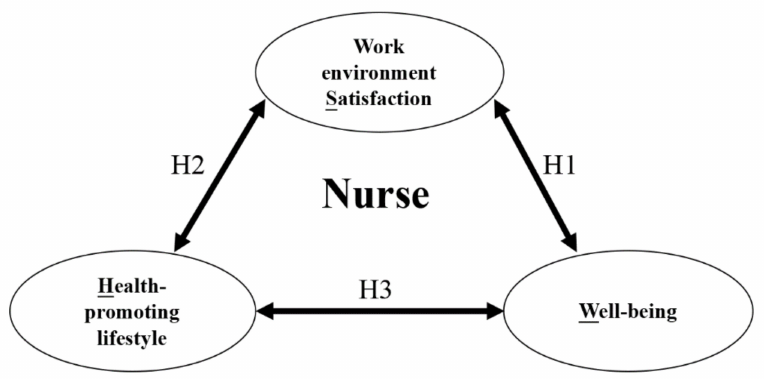
Figure1. ConceptualFrameworkIllustratingtheRelationshipsamongNurses’Well-being,Health-promoting lifestyles, and Work Environment